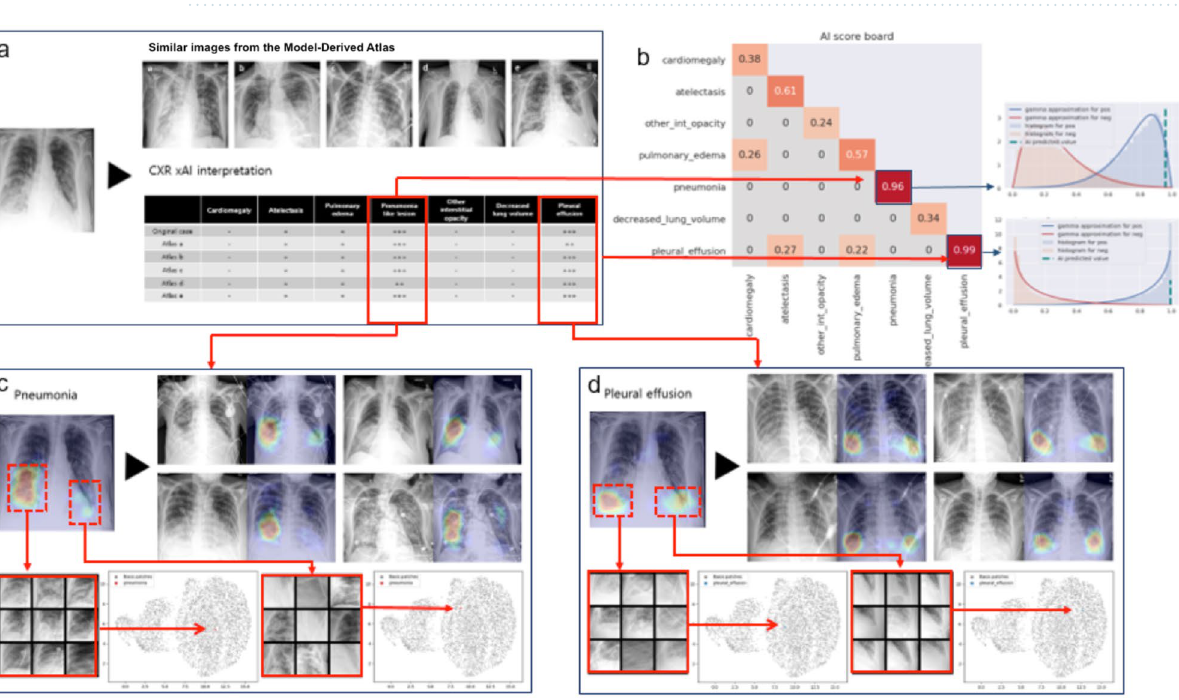
Figure 4. Interpretation table with similar CXRs selected from the Model-Derived Atlas. Visual comparison of the test image to similar CXRs with ground truth labels provides justification for model predictions. The table uses ‘−,’ ‘ + ,’ ‘ ++ ,’ and ‘ +++ ’ symbols to demonstrate similar combinations of pathological findings; prediction probability is ≥ 0.90 for ‘ +++ ’, < 0.90 and ≥ 0.80 for ‘ ++ ’, < 0.80 and ≥ 0.70 for ‘ + ’, and < 0.70 for ‘−’.